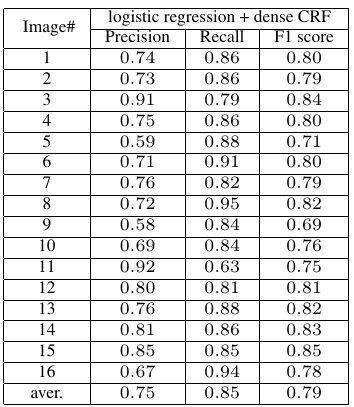
Figure 4. Example results of building detection: (a)(b)(c) detection results on the images shown in Figure 3; (d)(e)(f) ground truths. Table 1. Performance evaluation in terms of precision and